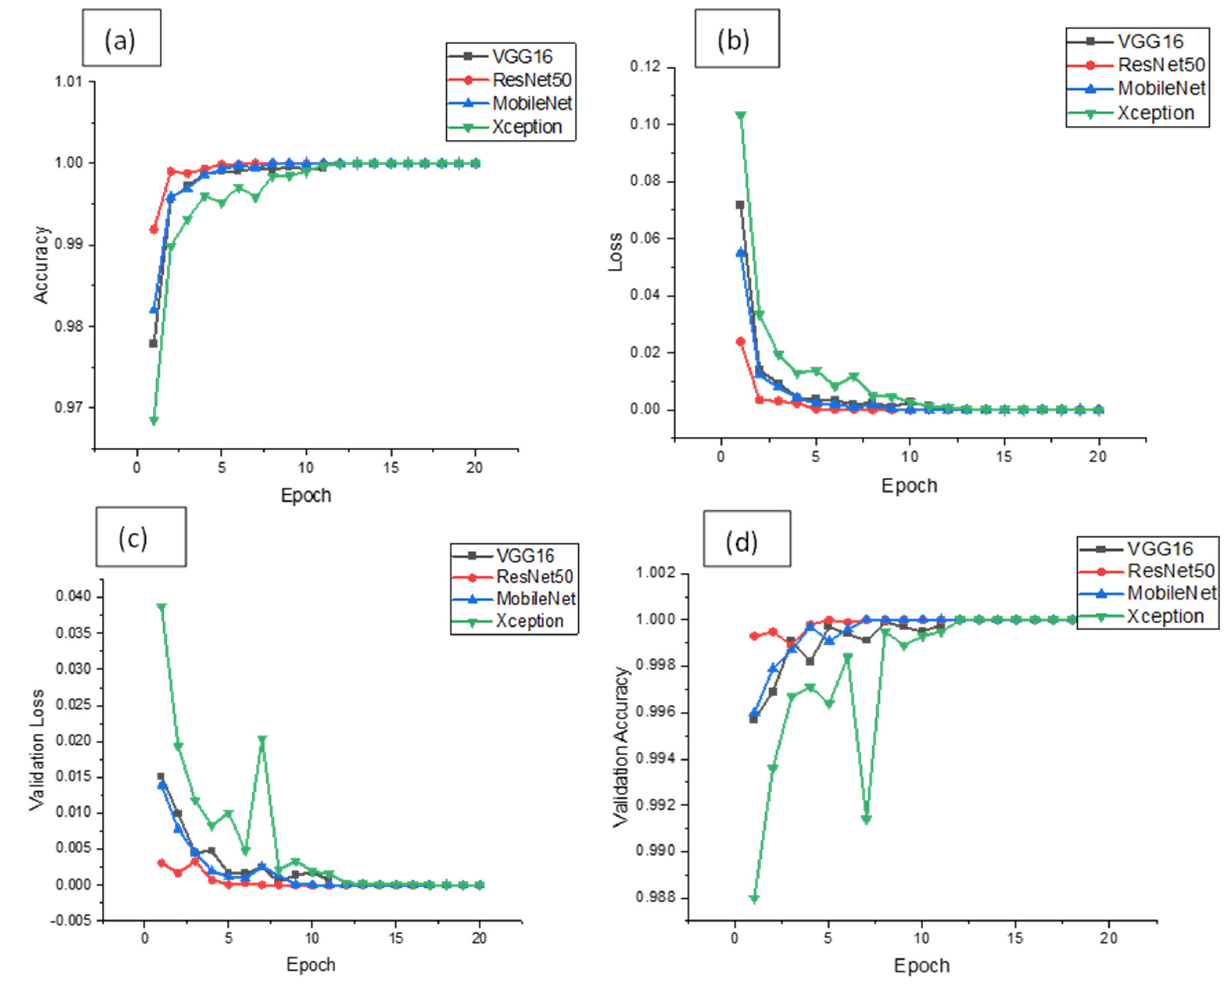
Figure 19. ( a ) Model accuracy ( b ) Model loss ( c ) Validation loss ( d ) Validation accuracy.